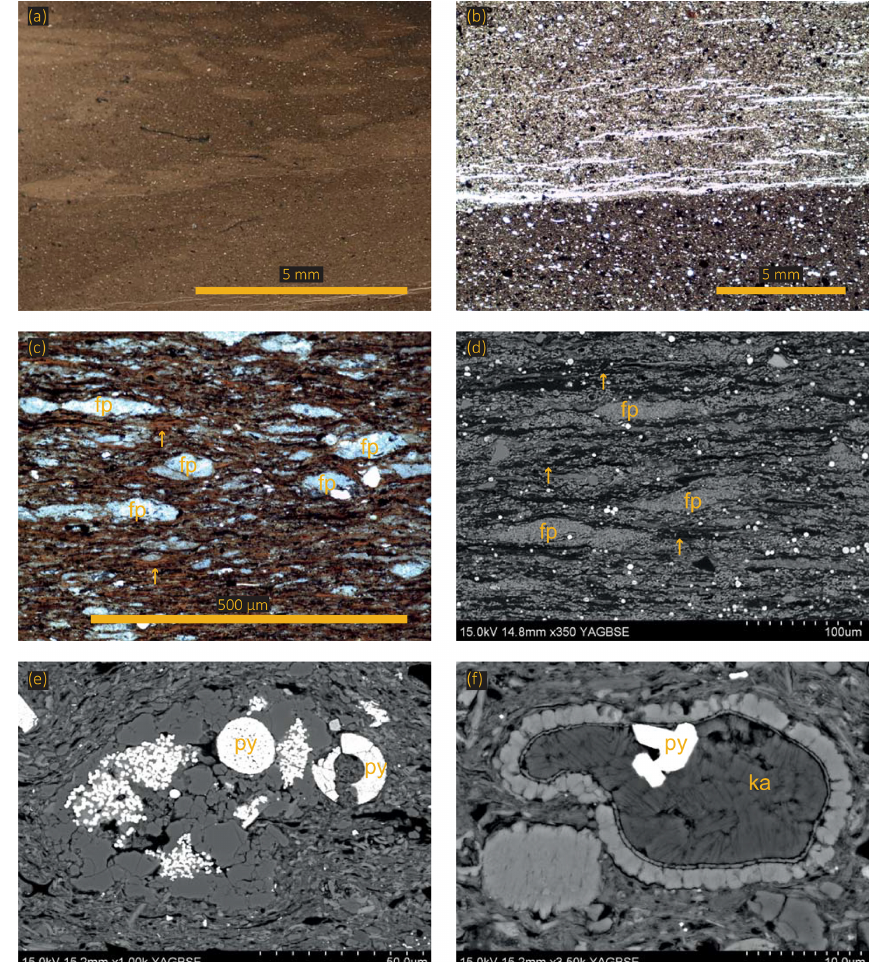
Figure 4. (a) Photomicrograph showing a bioturbated sample (lighter patches are burrows). (b) Optical micrograph of an erosional base. (c) Optical micrograph showing faecal pellets (fp) and algal mats (yellow arrows). (d) Same sample as in (c) . Scanning electron micro- graph showing faecal pellets (fp) and algal mats (yellow arrows). (e) Agglutinated foraminifera with pyrite (py) both as framboids and as a replacement mineral. (f) Scanning electron micrograph showing a calcitic test infilled with authigenic kaolinite (ka) and pyrite